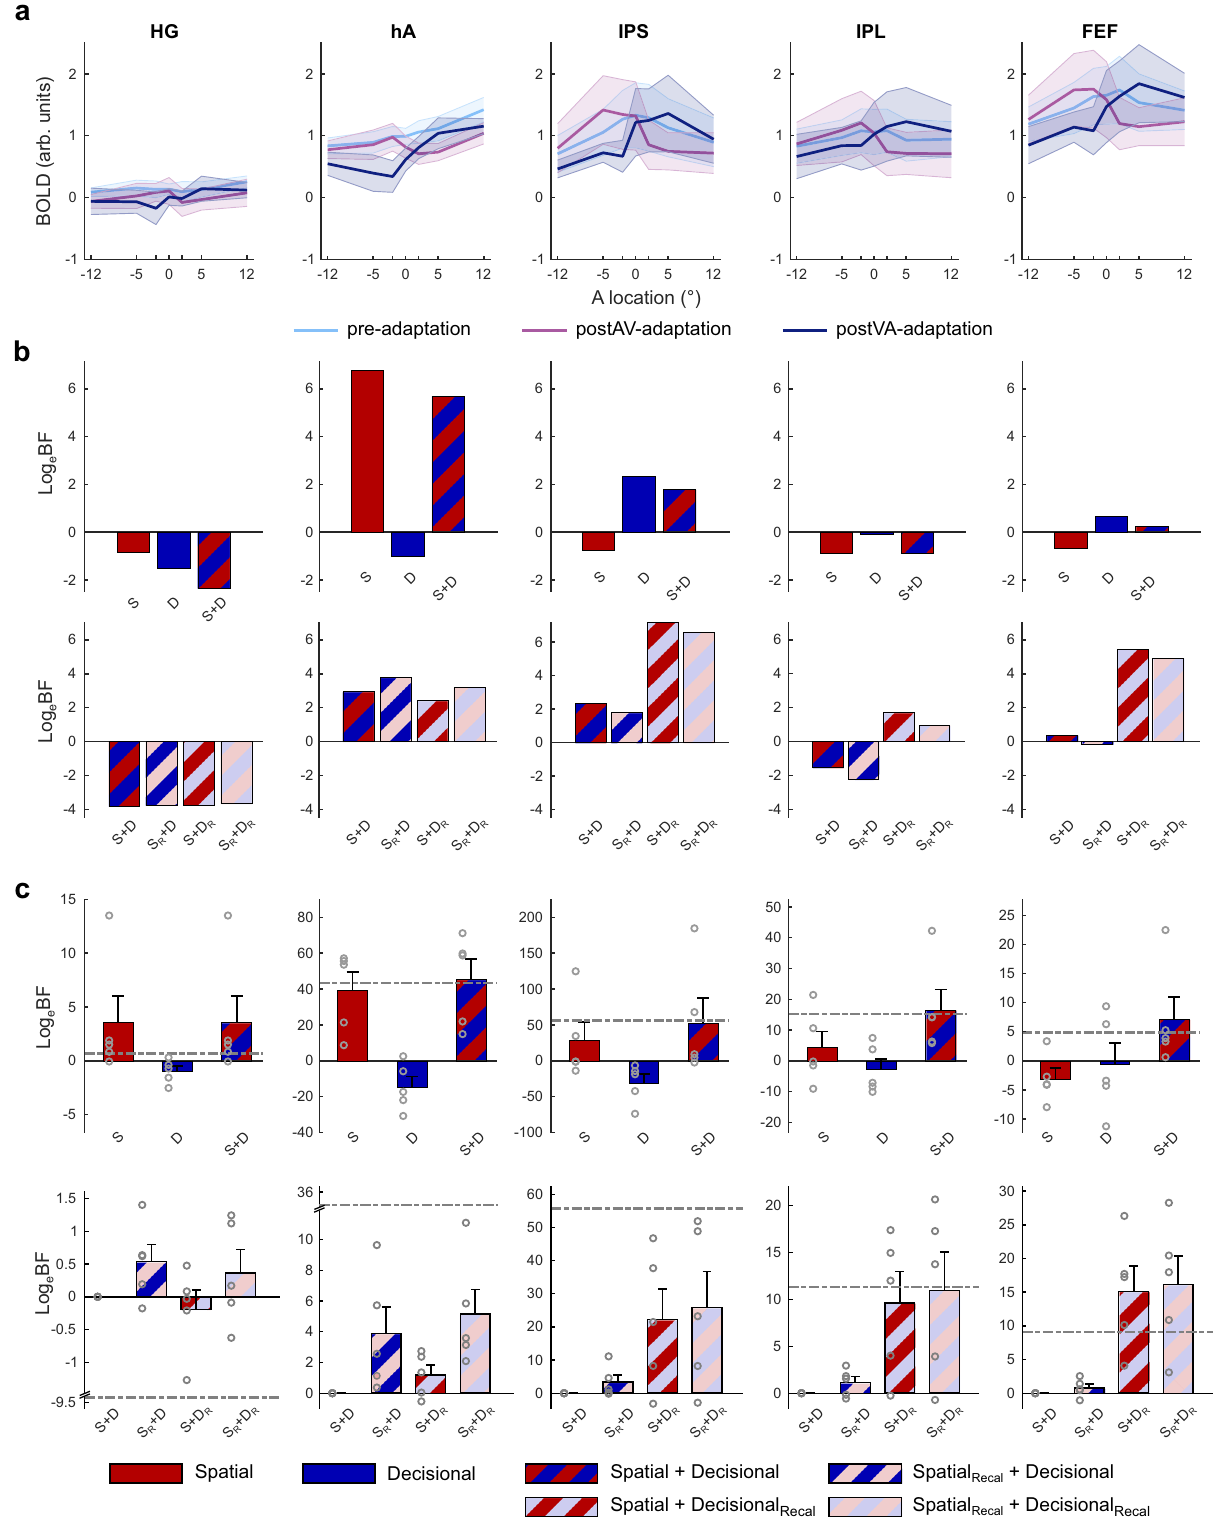
model component accounted for recalibration by shifting the ‘ encoded sound locations ’ by a constant ±2.3° (i.e. across-subjects ’ mean in behavioural PSE shift) to the right (postVA-adaptation) vs. left (postAV-adaptation). As shown in Fig. 4, the spatial and decisional uncertainty models make distinct predictions for the regional mean BOLD-response (Fig. 4b) and the similarity